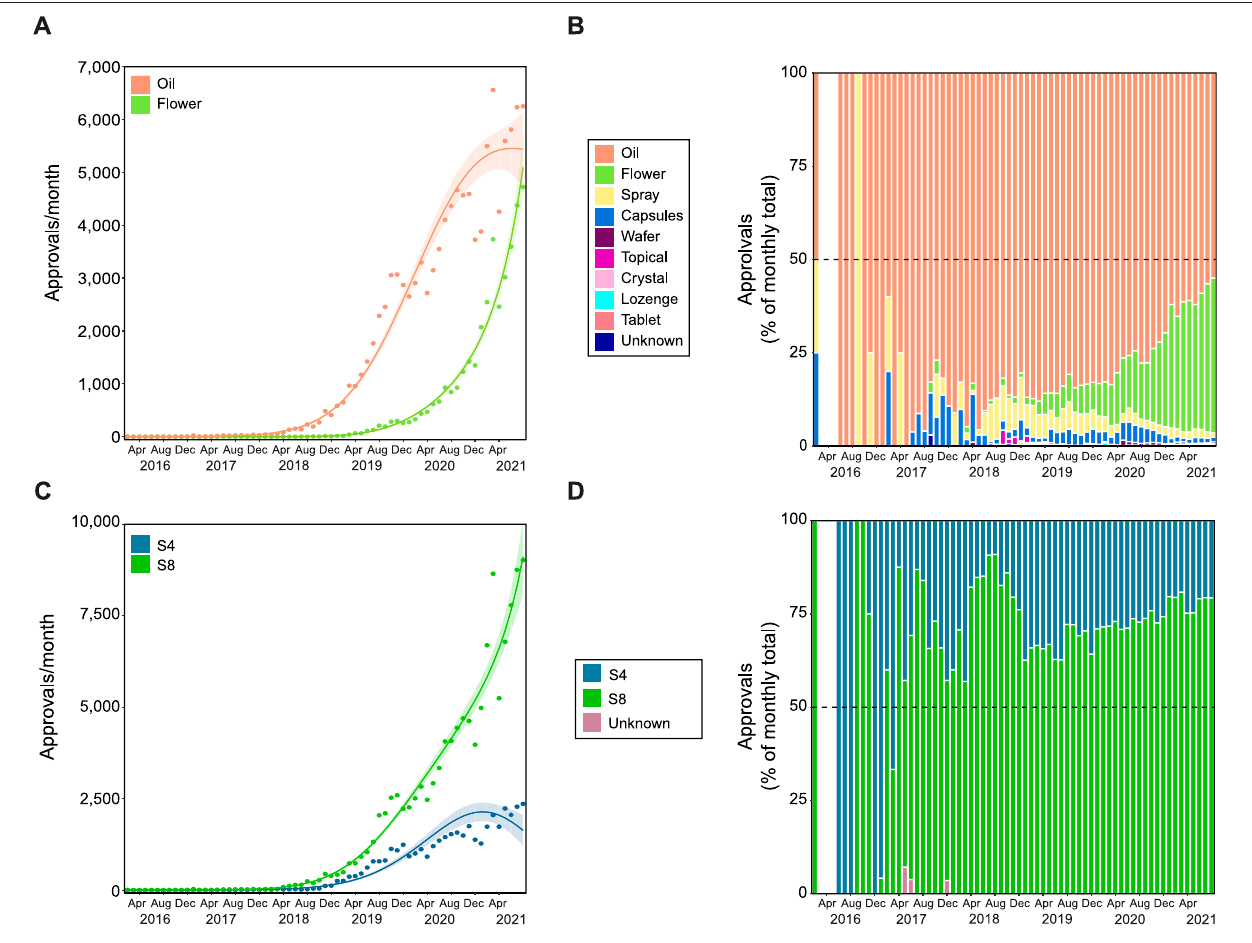
FIGURE 4 | Flower and Schedule 8 products have disproportionate growth. Growth trends in product format (A,B) and product schedule (C,D) . Approvals for oil products followed a Negative binomial 4th degree polynomial curve (R 2 = 0.980, Δ m = 18.292), while approvals for fl ower followed a Negative binomial 3rd degree polynomialcurve(R 2 =0.991, Δ m=8.267).Theproportion(%)ofapprovalsperproductcategory(seelegend)areshowninpanel (B) .ApprovalsforS4andS8products followed Negative binomial 4th degree polynomial curves (C; R 2 = 0.934 and 0.987, and Δ m = 11.691 and 15.707, respectively). The proportion (%) of approvals perproductschedule(seelegend)arepresentedinpanel (D) .Thegap(betweenFebruary2016andJune2016inpanels (B) and (D) ,indicatesnoapplicationssubmitted in this period. In panels (A) and (C) Solid lines represent best fi t with shaded standard error of the